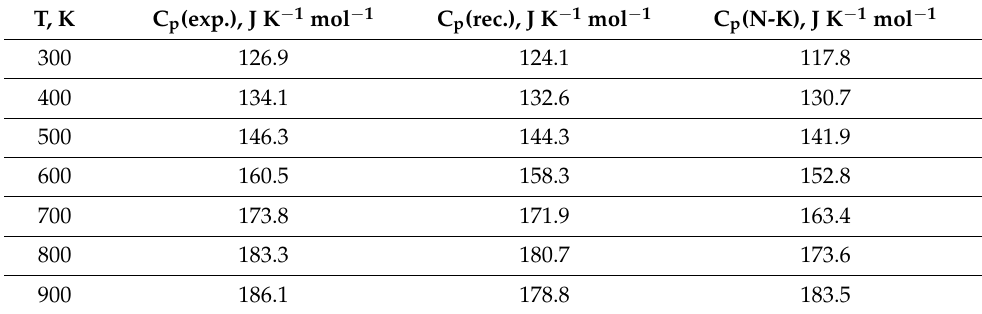
Table 5. The temperature dependence of the experimental (exp.), recalculated by Equation (14) (rec.), and calculated by the Neumann–Kopp (N-K) rule (Equation (17)) heat capacities (Cp) of Li 3 FeN 2 (s). T,